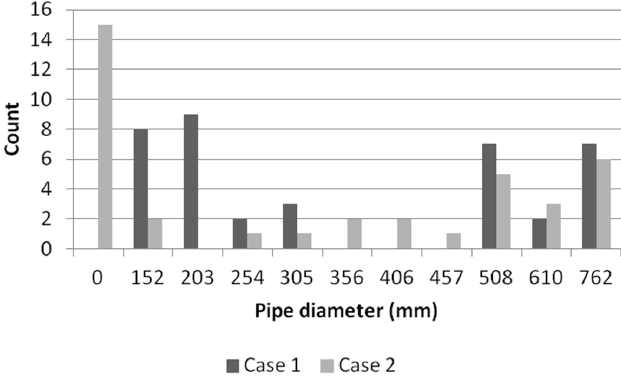
Figure 5. Pipe layout comparison for the solutions obtained from Cases 1 and 2 (Figure 4); pipe diameters are in mm; the thicker and darker pipe is larger. ( a ) Case 1; ( b ) Case 2.